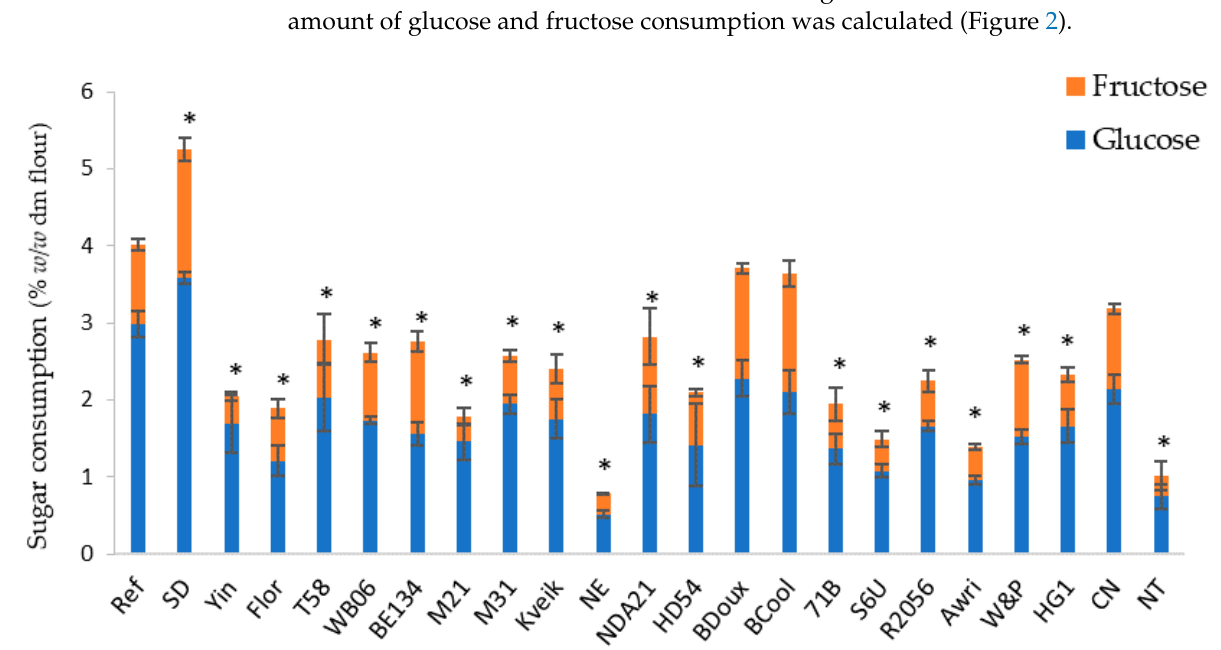
Figure 2. Glucose and fructose consumption levels in sweet doughs (14% sugar, w / w dm flour) with 23 different yeast strains after a fermentation step of 120 min at 30 ◦ C. Concentrations are expressed on flour dry matter base (% w / w dm flour). The standard deviations result from triplicate measurements. ‘*’ indicates concentrations that were significantly different from the reference ( p < 0.05).